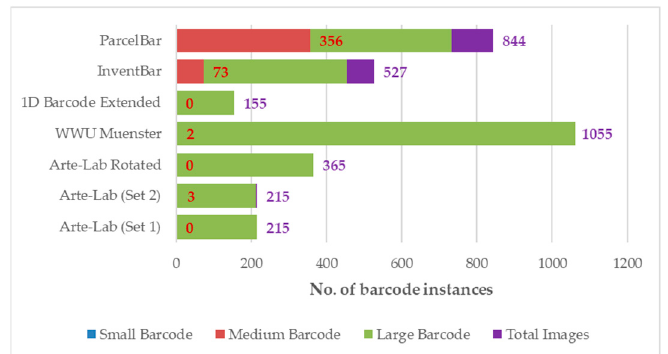
Figure 3. Number of annotated barcode instances classified by barcode size: small, medium, and large.